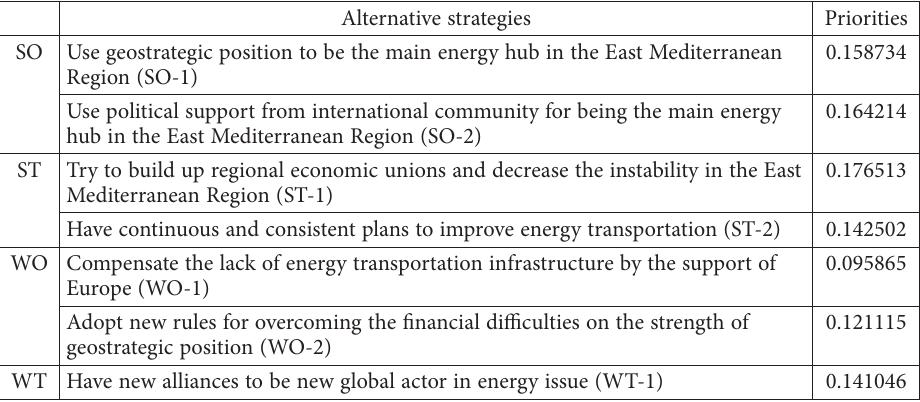
Table 9. The priorities of alternatives obtained by ANP Alternative strategies